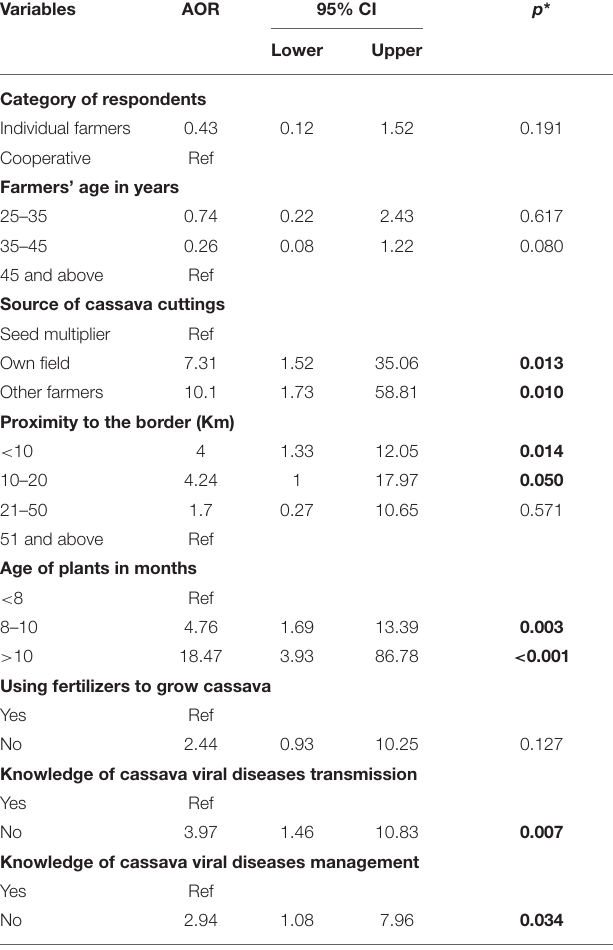
TABLE 4 | Factors associated with